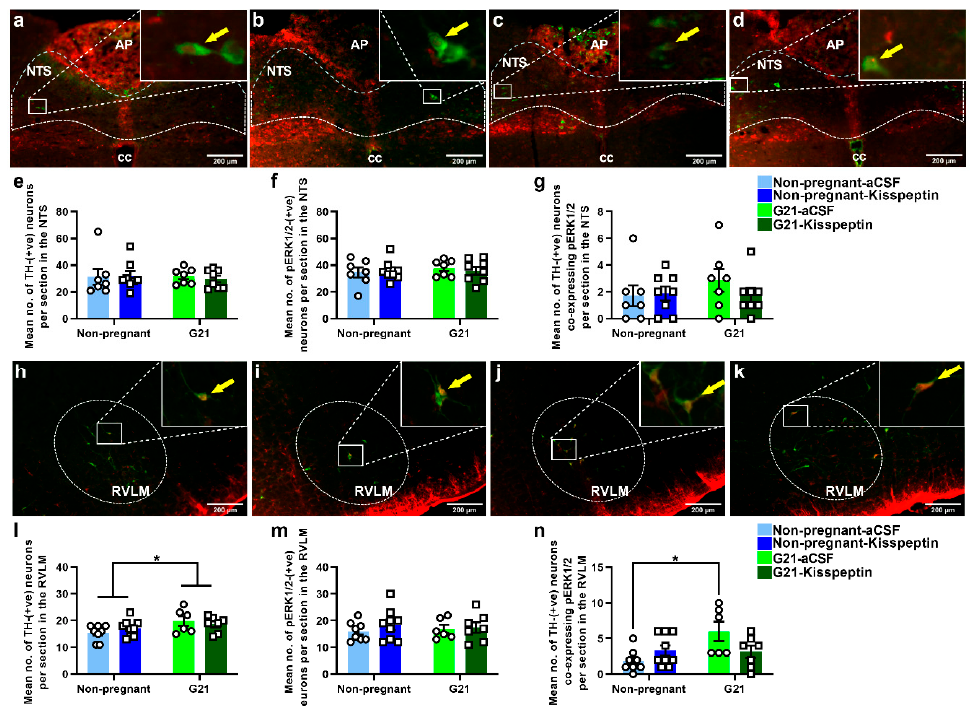
Figure 5. Kisspeptin does not affect pERK1/2 expression in NTS or RVLM noradrenergic neurons of non-pregnant and G21 rats. Photomicrographs of coronal NTS ( a – d ) and RVLM ( h – k ) sections, within the white dotted area, showing TH-positive neurons (green) and pERK1/2-positive neurons (red) in non-pregnant rats ( a , b , h , i ) and G21 rats ( c , d , j , k ) after ICV administration of aCSF ( a , c , h , j ) or kisspeptin (2 µg in 2 µL; b , d , i , k ). Yellow arrows point to representative pERK1/2 and TH co-labelling. Mean (± SEM) number of ( e ) TH-positive neurons (RS: F (1,1) = 0.058, p = 0.810; T: F (1,1) =